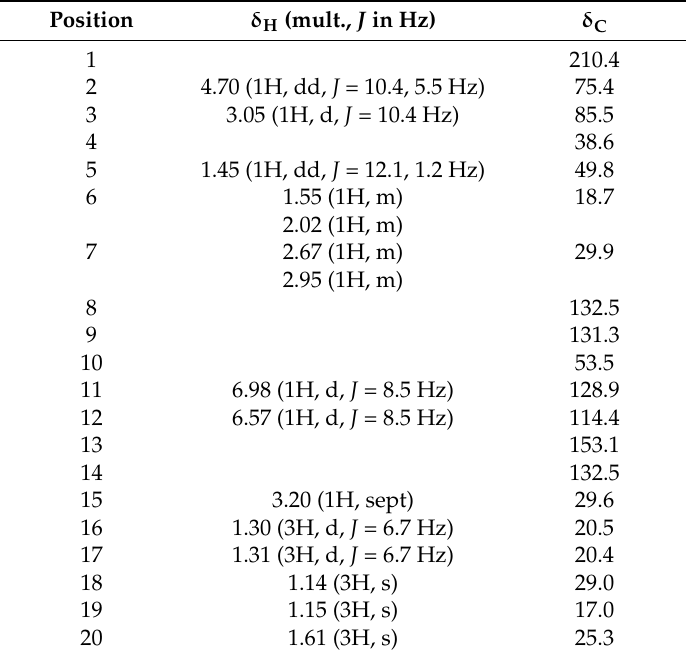
Table 3. 1 H- and 13 C- NMR spectral data of 3 (CDCl 3 , 500